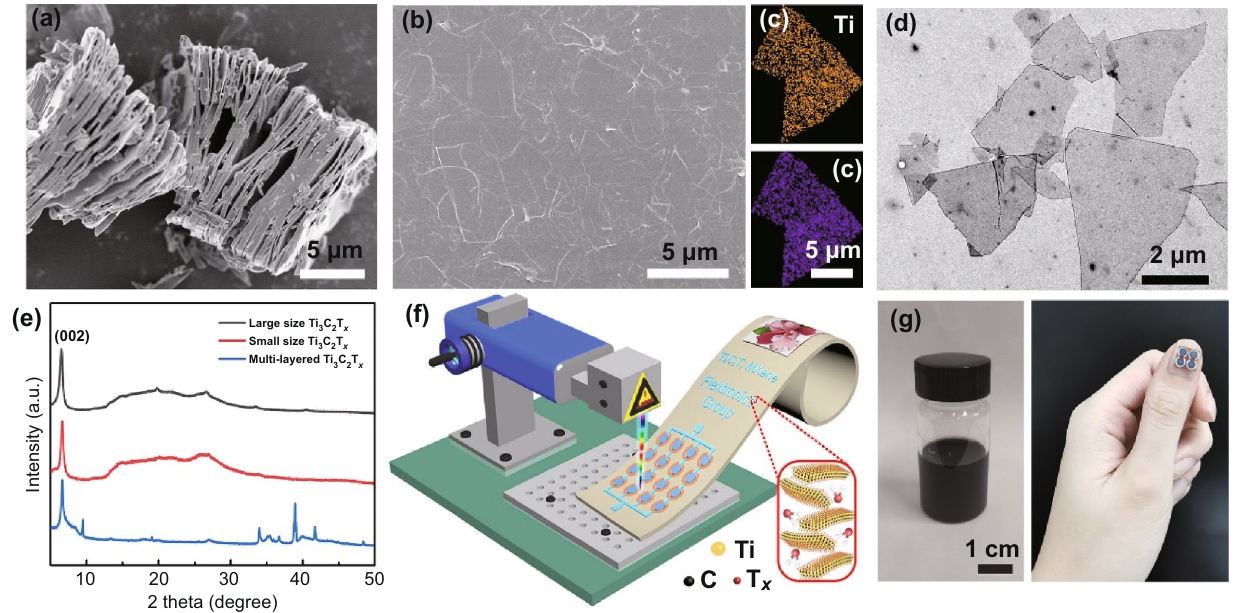
Fig. 1 Morphology, crystallinity of the synthesized Ti 3 C 2 T x materials, and the fabrication process of the Zn-ion hybrid MSCs array. a SEM image of the multi-layer Ti 3 C 2 T x MXene. b SEM image of the monolayer Ti 3 C 2 T x MXene with large size. c Elemental mapping images showing the dispersion of Ti and C elements in the Ti 3 C 2 T x MXene. d TEM image of the sonicated monolayer Ti 3 C 2 T x MXene with small size. e XRD patterns of the multi and monolayered Ti 3 C 2 T x MXenes. f Schematic diagram exhibiting the fabrication process of the patterned MSCs array via laser writing technology. g Digital photos of the Ti 3 C 2 T x supernate and the fabricated micro device array directly attached to the